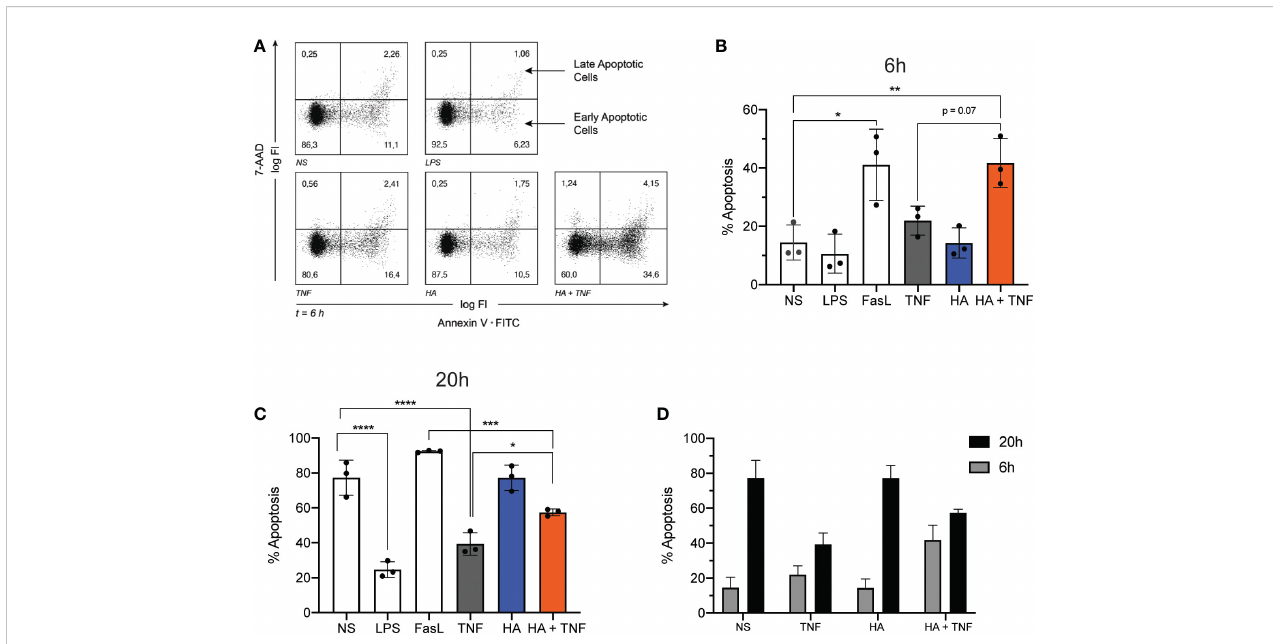
FIGURE 5 Neutrophil apoptosis in co-stimulated neutrophils. (A) Representative dot plots show Annexin V (x-axis; log fl uorescence intensity (log FI)) and 7-AAD (y- axis; log FI) staining of neutrophils following ex vivo culture for 6 h (t = 6 h) in the absence of stimuli (NS) or presence of LPS (100 ng/mL), TNF a (10 ng/ mL), HA (200 m g/ml), or HA + TNF a . Staining denotes viable (lower left quadrant, Annexin V – 7-AAD – ), early apoptotic (lower right quadrant, Annexin V+ 7-AAD – ) and late apoptotic (upper right quadrant, Annexin V+ 7-AAD+) neutrophils. Dot plot is representative of 3 independent experiments